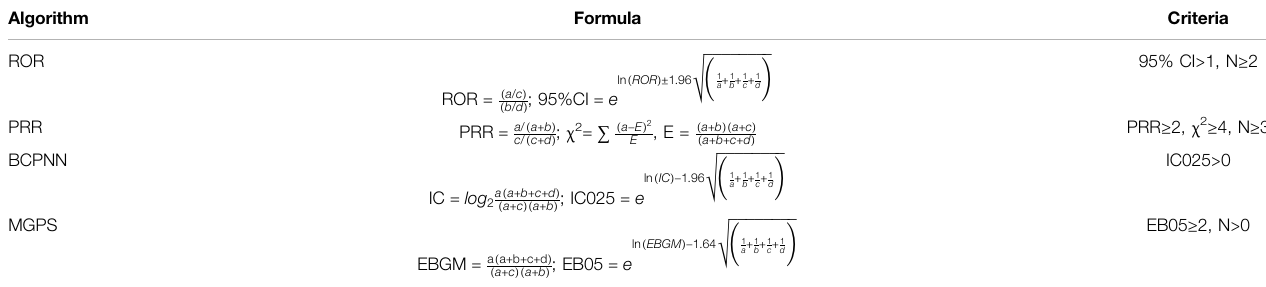
TABLE 1 | Formulae and criteria of four algorithms for signal detection. Algorithm Formula Criteria